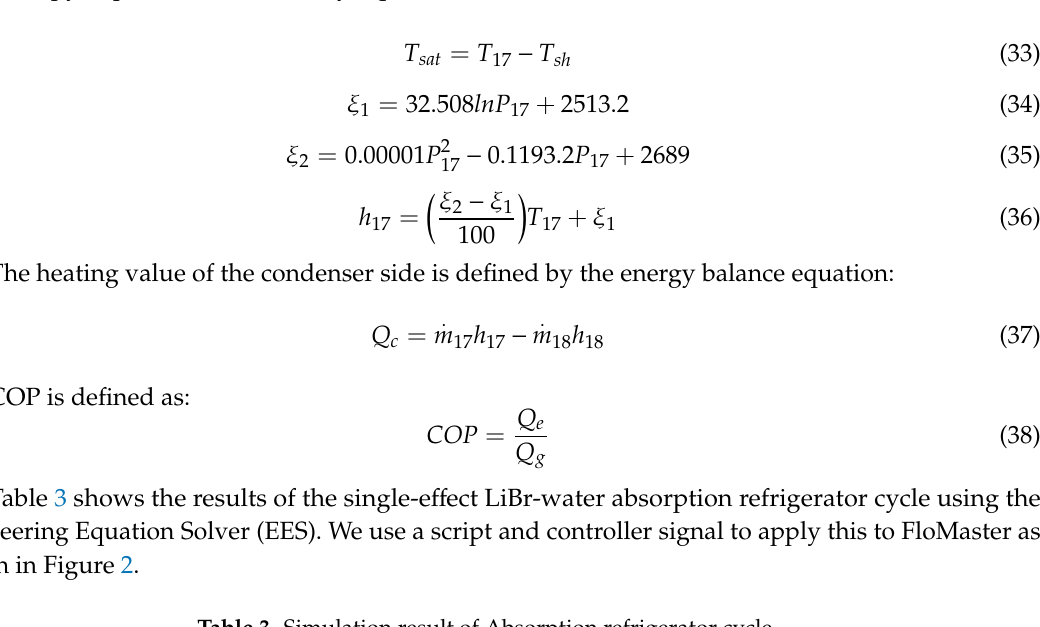
Table 3. Simulation result of Absorption refrigerator